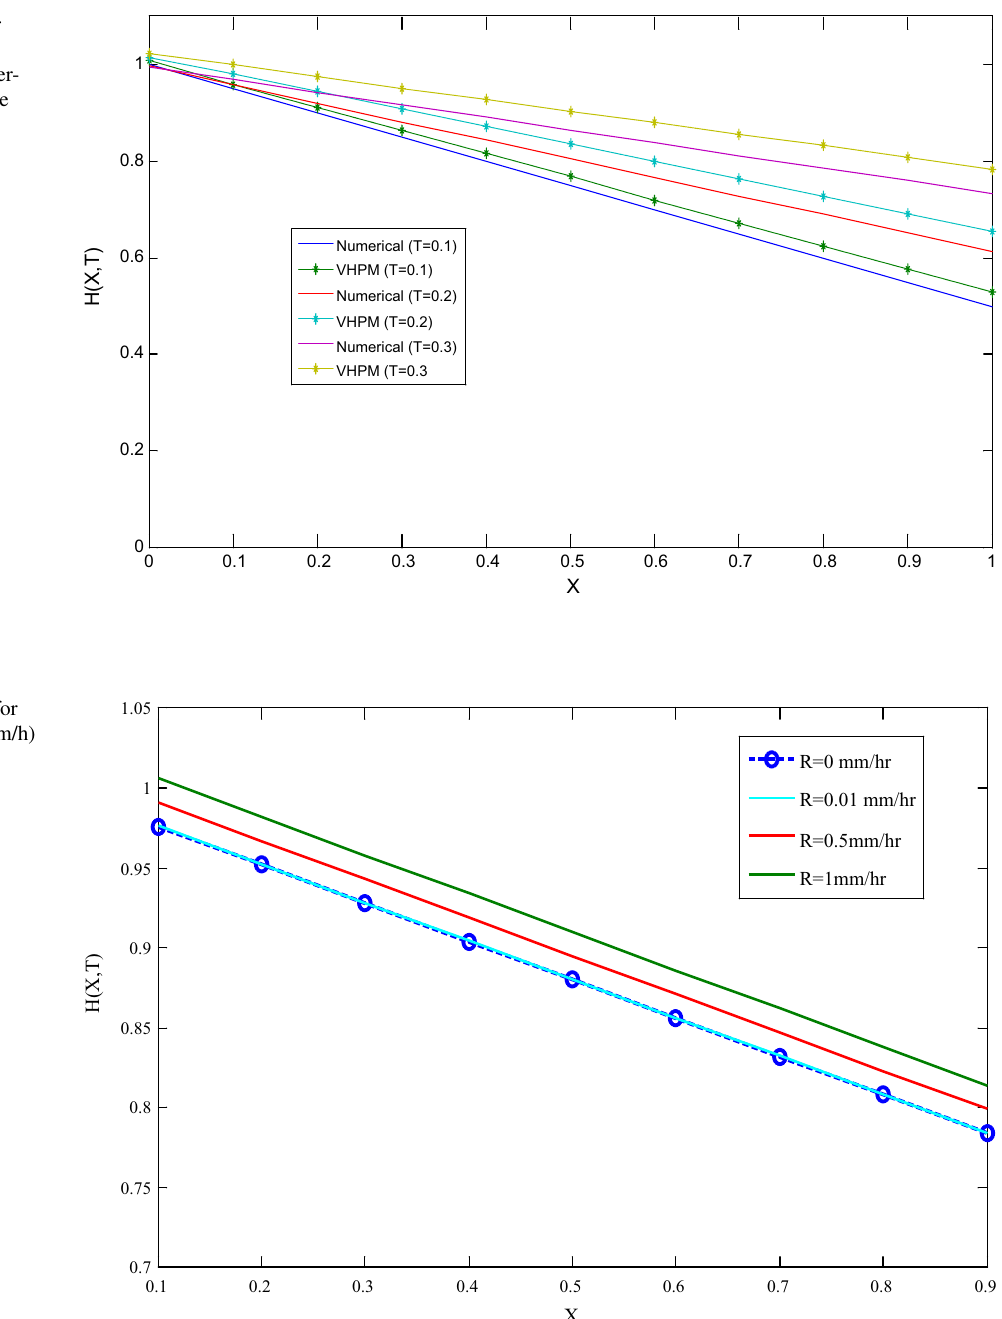
Fig. 5 Comparison of water table profiles in unconfined aquifer with horizontal imper- meable bed without recharge